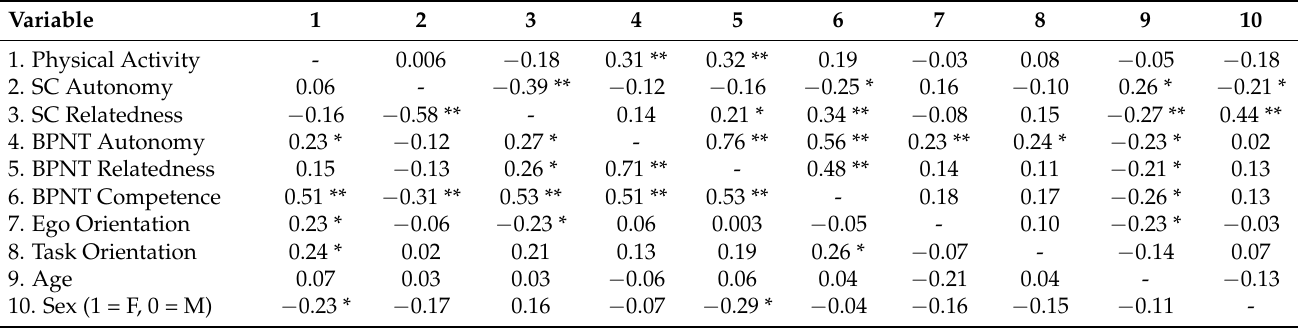
Table 2. Correlations among study variables for the U.S. and Turkey